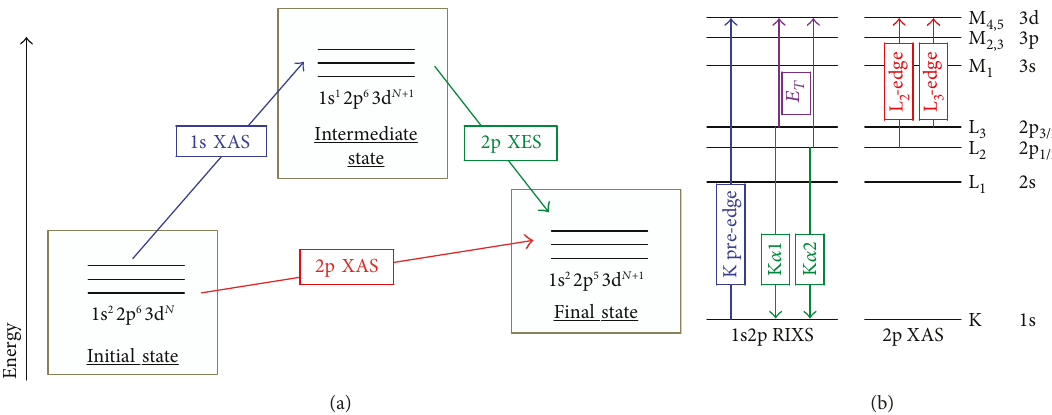
Figure 1: Scheme (a) illustrates the di ff erent pathways in the two-step 1s2p RIXS process, composed of the 1s XAS (K pre-edge) and 2p XES ( K α decays) transitions and the direct 2p XAS (L in 1s2p RIXS and 2p E T